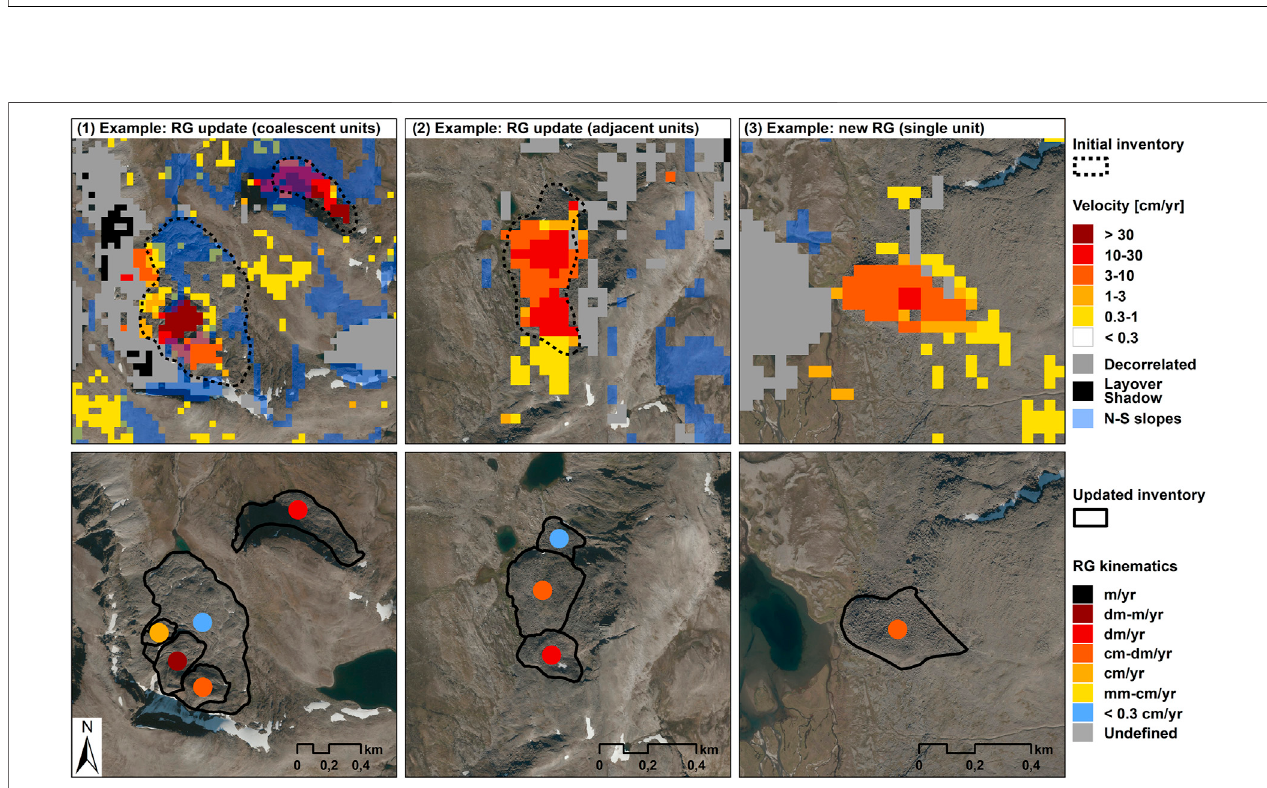
FIGURE8| Updateoftherockglacier(RG)inventory.Examplesof (1) coalescentunitswithintwosystems, (2) adjacentunitswithinonesystem, (3) newlydetected singleunit.Upperpanel:classi fi edInSARresultsandinitialinventory.Lowerpanel:updatedinventorywithassociatedkinematicattributeforeachunit.Locationsofthese detailed maps are shown in Figure 9 . Norge i bilder orthophotos from NMA (2020b).